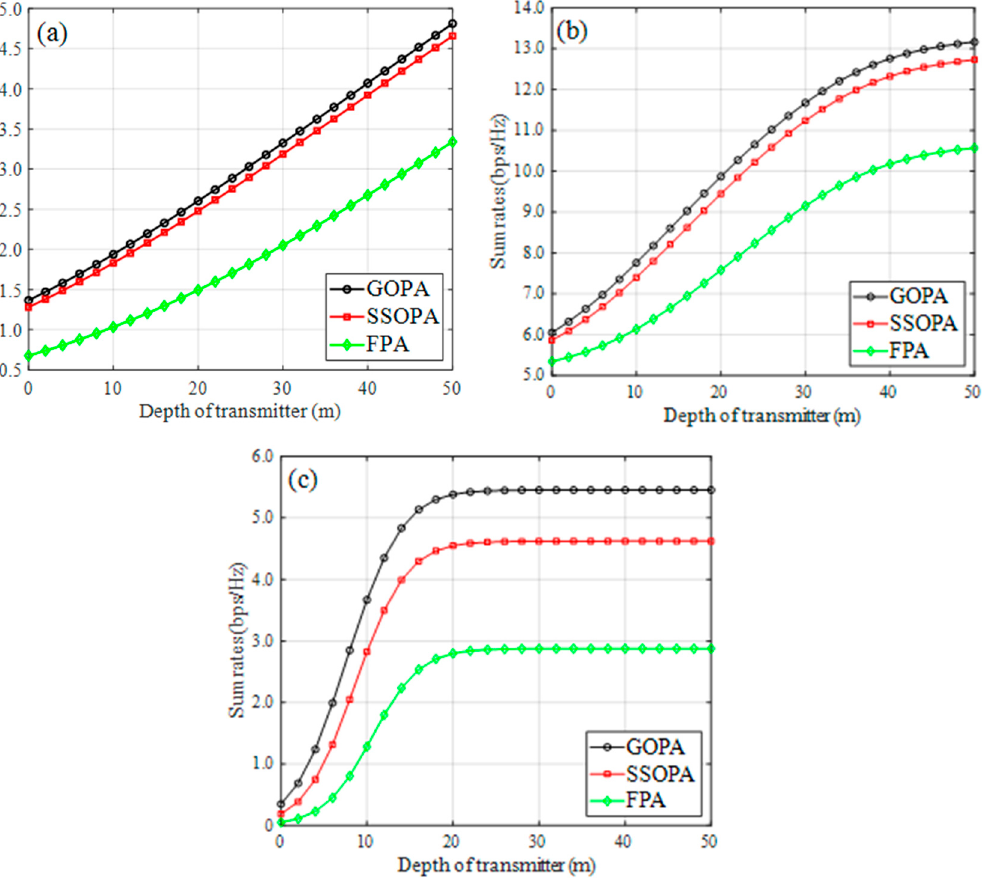
Figure 8. Sum rates versus depth of transmitter for ICNOMA system for: ( a ) clear ocean water, ( b ) pure ocean water, and ( c ) coastal water.